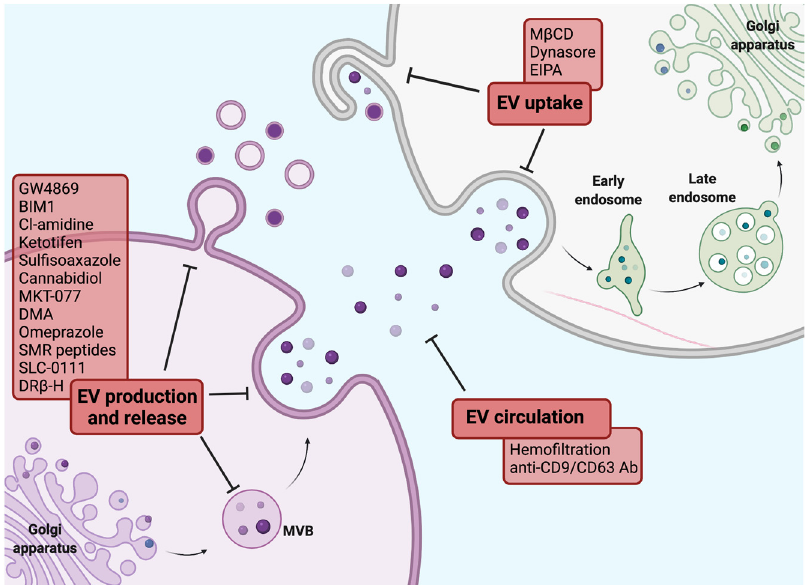
Figure 4. Potential therapeutic interventions targeting EV pathways. The exosome and microvesicle pathways can be targeted at various biological stages including biogenesis, release, circulation and uptake. (Abbreviations: BIM1, Bisindolylmaleimide-I, Cl-amidine, chloramidine; DMA, Dimethyl Amiloride; DR β -H, D Rhamnose β -hederin; EIPA, ethyl isopropyl amiloride; EV, extracellular vesicles; M β CD, Methyl- β -cyclodextrin; MVB, multivesicular bodies; SMR, secretion modification region). Lipid-related pathways such as the conversion of sphingomyelin to ceramide by sph- ingomyelinases, phosphatidylserine (PS) translocation by protein kinases and